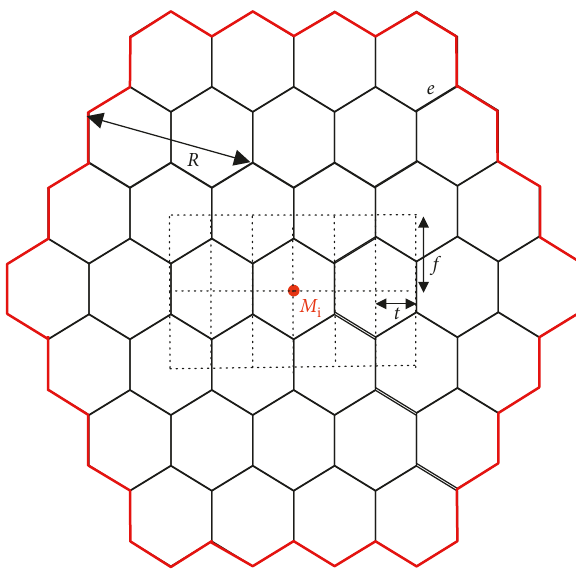
Figure 2: Structure of the honeycomb cluster with 3 cell